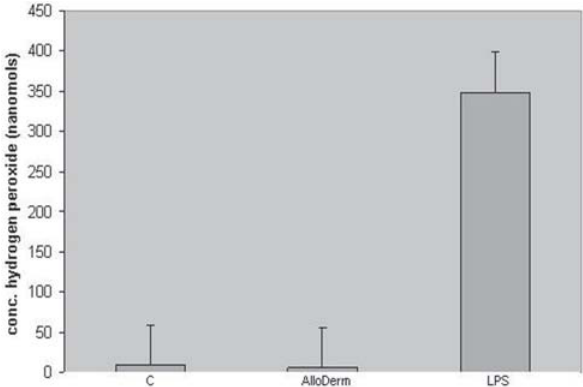
FIGURE 2- Production of hydrogen peroxide by peritoneal macrophages cultured with medium, acellular dermal matrix and Zymosan (250µg/well). In the test phenol red was used as indicator of presence of hydrogen